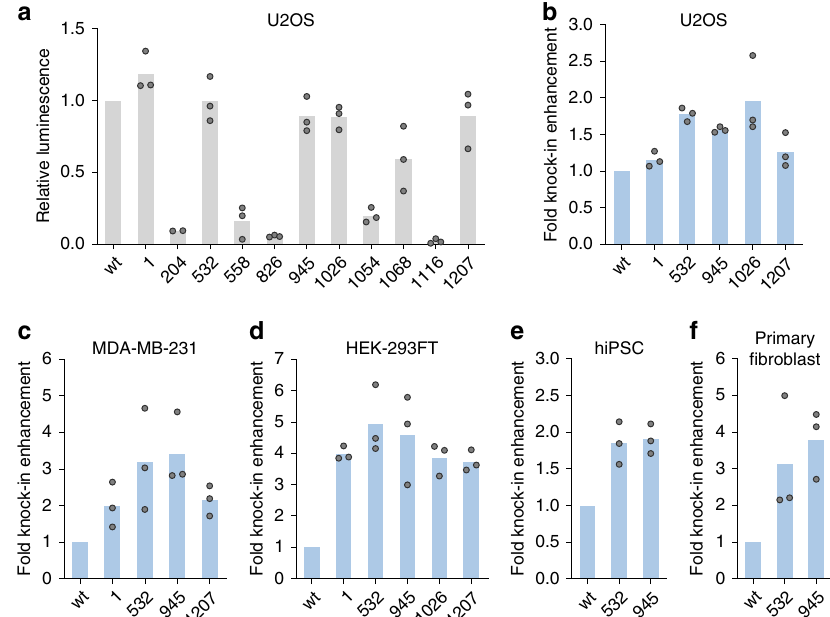
Fig. 2 Unitary display of ssODN on Cas9 domains enhances HDR in multiple cell types. a HiBiT knockin ef fi ciencies by Cas9-adaptor conjugates compared to unlabeled wild-type Cas9 (wt) when a separate Cas9/ssODN system was used ( n = 3 biologically independent experiments except for 204 where n = 2). b – f ssODN display on Cas9 enhances HiBiT knockin ef fi ciency in various cells: b U2OS, c MDA-MB-231, d HEK-293FT, e human-induced pluripotent stem cells, and f primary human neonatal dermal fi broblasts. Unlabeled wild-type Cas9 (wt) and Cas9-adaptor conjugates labeled at the indicated residues were used ( n = 3 biologically independent experiments). Source data are provided as a Source Data fi